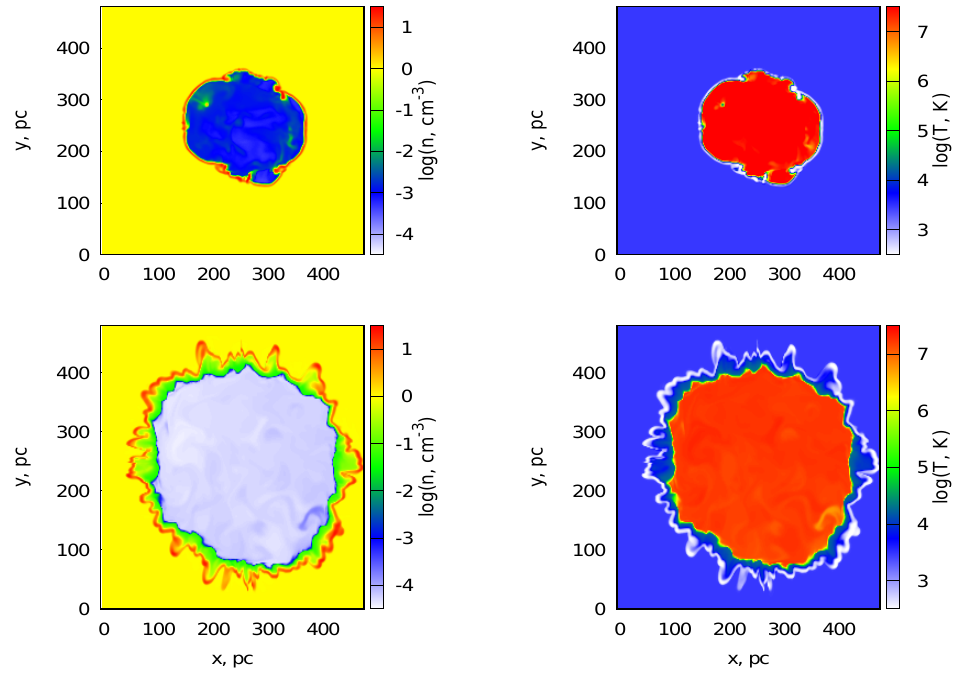
Figure 1. The density (left column) and temperature (right column) slices at z = 250 pc for isolated bubble formed by multiple SN explosions in a cluster at time moments 2 Myr (upper panels) and 6 Myr (lower